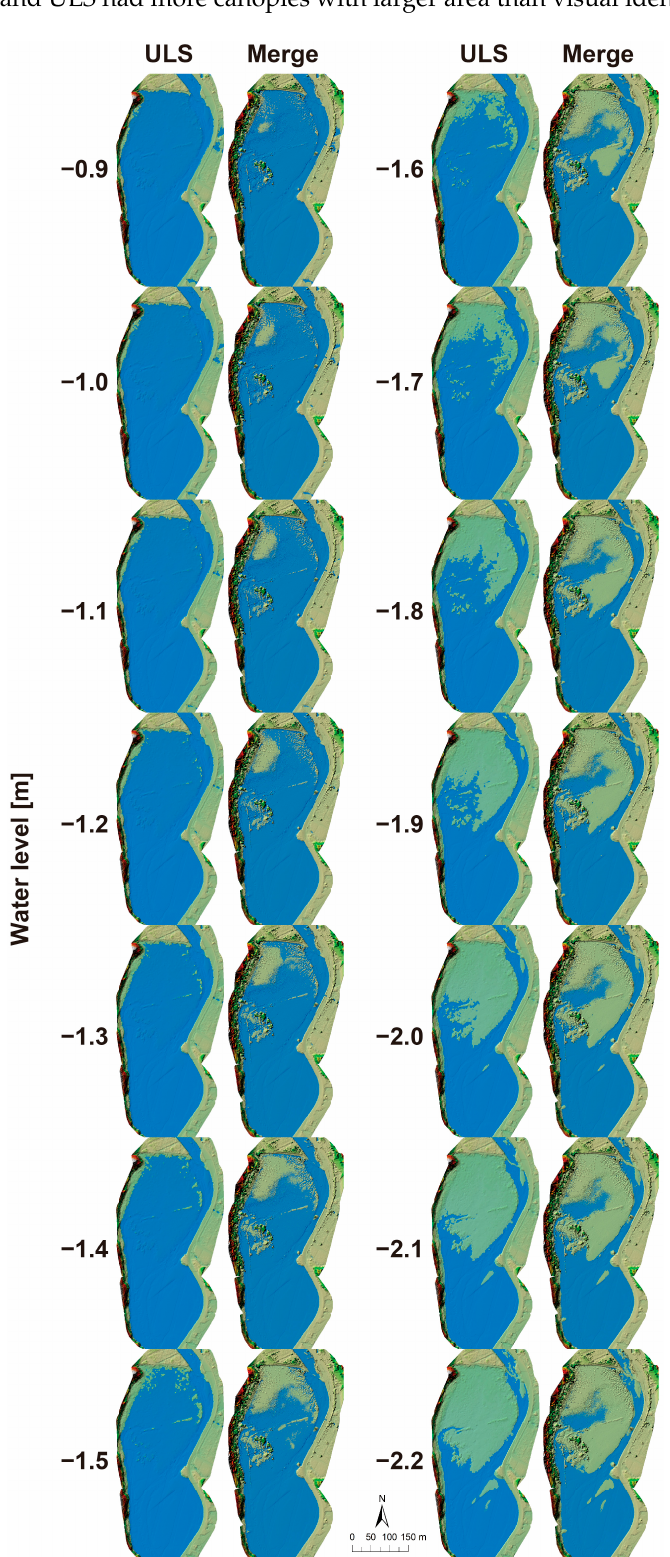
Figure 4. Simple tidal simulation with water levels varying every 10 cm. Blue indicates flooded